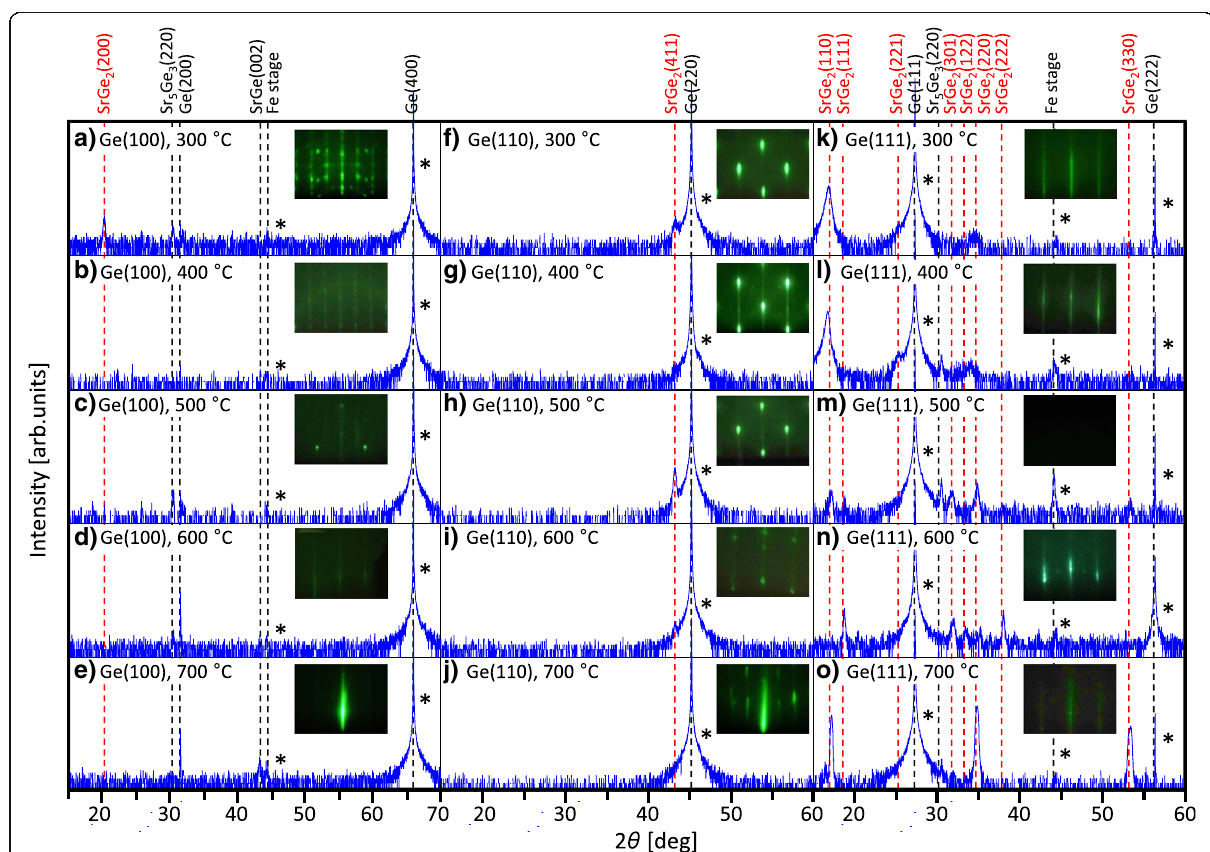
Fig. 1 RHEED and θ – 2 θ XRD patterns of the samples after the Sr deposition. The crystal orientation of the Ge substrate is a − e (100), f − j (110), and k − o (111). T sub is ranged from 300 to 700 °C for each substrate. The peaks corresponding to SrGe 2 are highlighted in